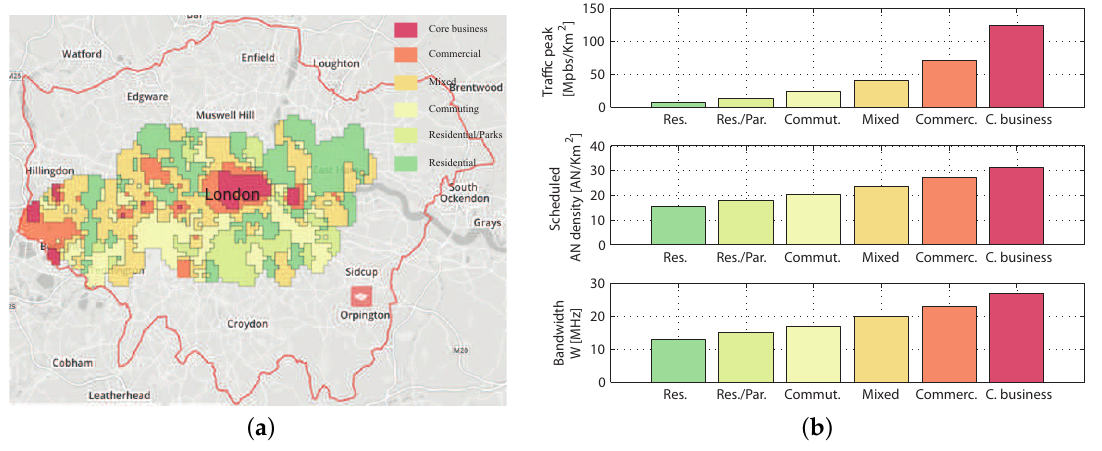
Figure 7. An illustration of the resource density scheduler allocation for an ultra-dense network deployed in a metropolitan area characterized by a traffic intensity map. The city area is divided into clusters representing regions with similar traffic intensity at a given time of the day. ( a ) Example of traffic intensity map for a metropolitan area (cf. http://senseable.mit.edu/manycities/). The city is divided into clusters representing different types of areas. Each cluster is associated with a traffic intensity. ( b ) Traffic intensity of each cluster and the corresponding resource allocation for the radio access network determined by the resource density